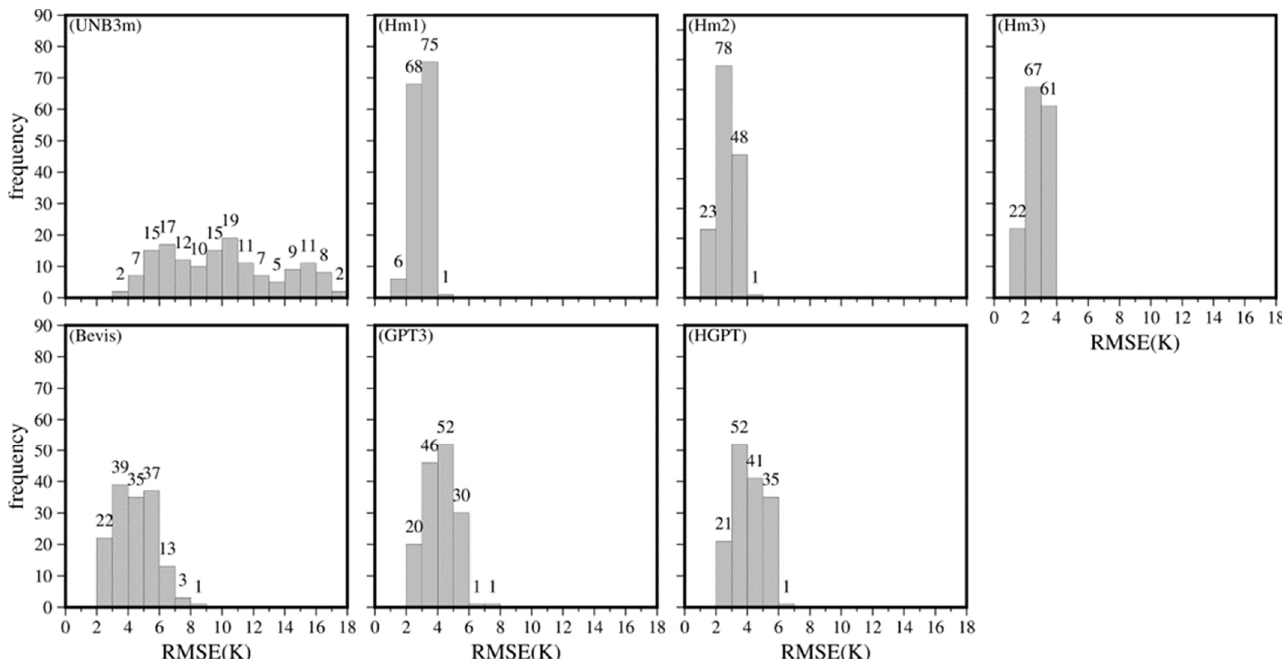
Figure 8. Spatial distribution of the RMSE that are calculated cross-validation residuals at each radiosonde station for ( a ) UNB3m model, ( b ) Hybrid model 1, ( c ) Hybrid model 2, ( d ) Hybrid model 3, ( e ) Bevis model, ( f ) GPT3 model, and ( g ) HGPT model.